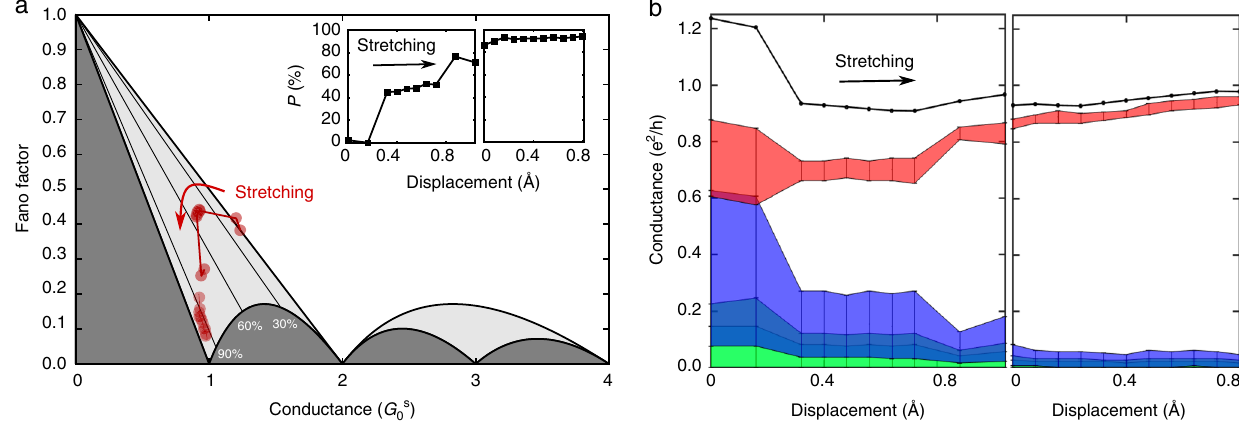
Fig. 3 Experimental analysis of spin-polarized transport during elongation of Ag/vanadocene junctions. a Fano factor versus conductance during the elongation of two different Ag/vanadocene junctions. Following each measurement, the junction is stretched by 0.1 – 0.05 Å. The uncertainty, corresponding to systematic errors in our measurements, is comparable to the symbols ’ diameter, as shown in Supplementary Fig. 4. Inset, lower bound for CSP ( P is the minimal P G ), as determined by the experimentally obtained Fano factor and conductance, with ±3% experimental uncertainty. b Total conductance (black dots, error range is given by dots ’ diameter) and transmission probabilities of the largest four spin-polarized transmission channels (colors). The large uncertainty in the transmission probabilities, indicated by the error bars, stems from the numerical analysis (Supplementary Note 5). As the junction is stretched, the conductance evolves towards the upper limit of ballistic spin-polarized transmission, with conductance approaching G s polarization approaching 100%, and electron transport that is dominated by a single spin-polarized transmission channel (red-shaded). Here, the maximal values are: G = 0.98 ± 0.01 G s , P G ≥ 95 ± 3%, with signi fi cant suppression of all spin channels except one. Additional examples for the evolution of 0 transport properties as a function of junction elongation appear in Supplementary Fig. 7. See also Supplementary Note